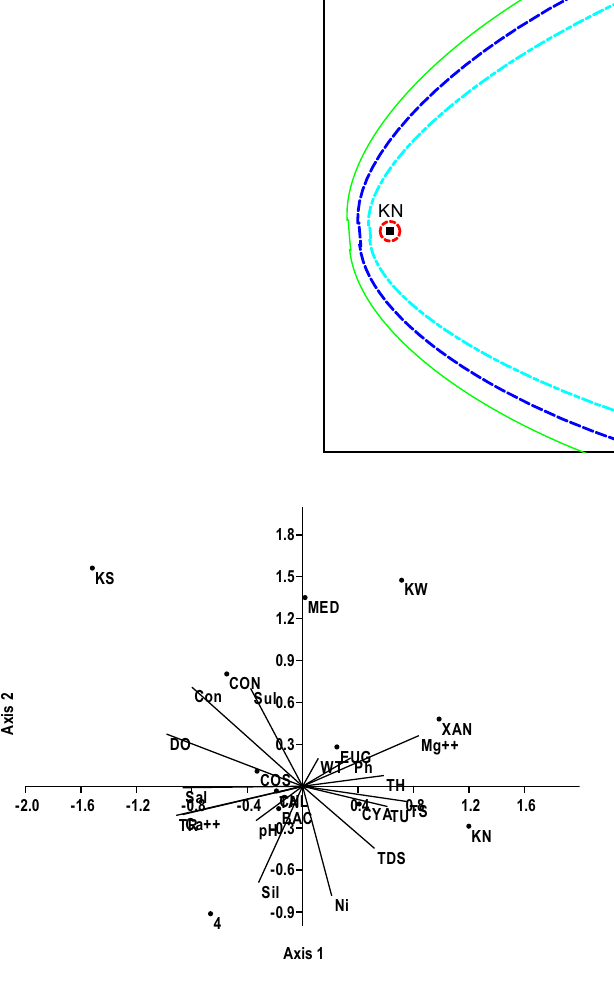
Fig. 6 CCA biplot (sites) drawn between physicochemical parameters and algal groups